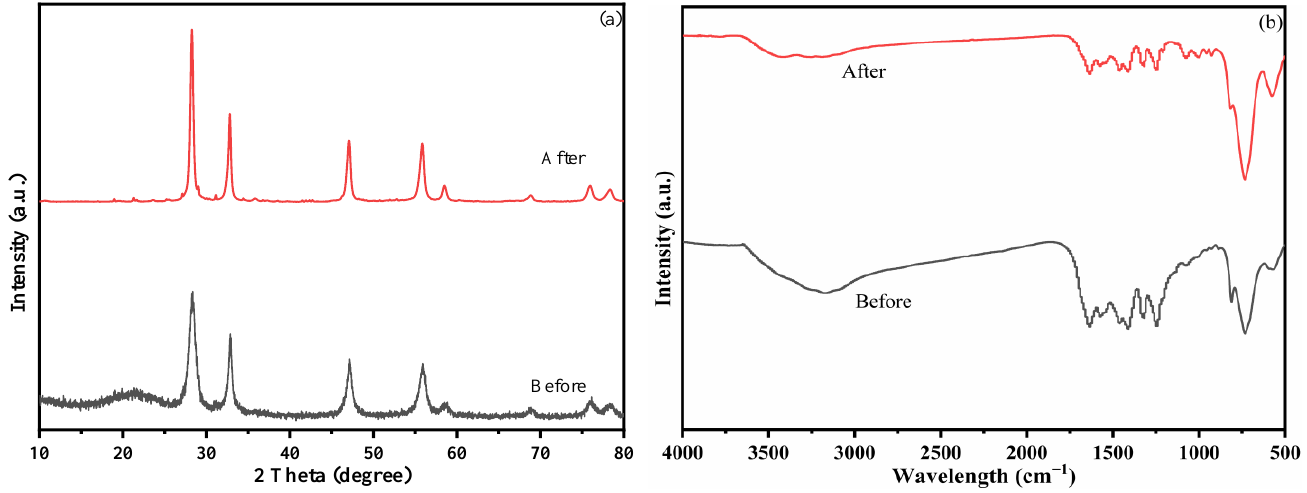
Figure 12. ( a ) XRD patterns and ( b ) FTIR spectra of 30% PCNS/BWO before and after cycling exper- ( a ) XRD patterns and ( b ) FTIR spectra of 30% PCNS/BWO before and after iment. cycling